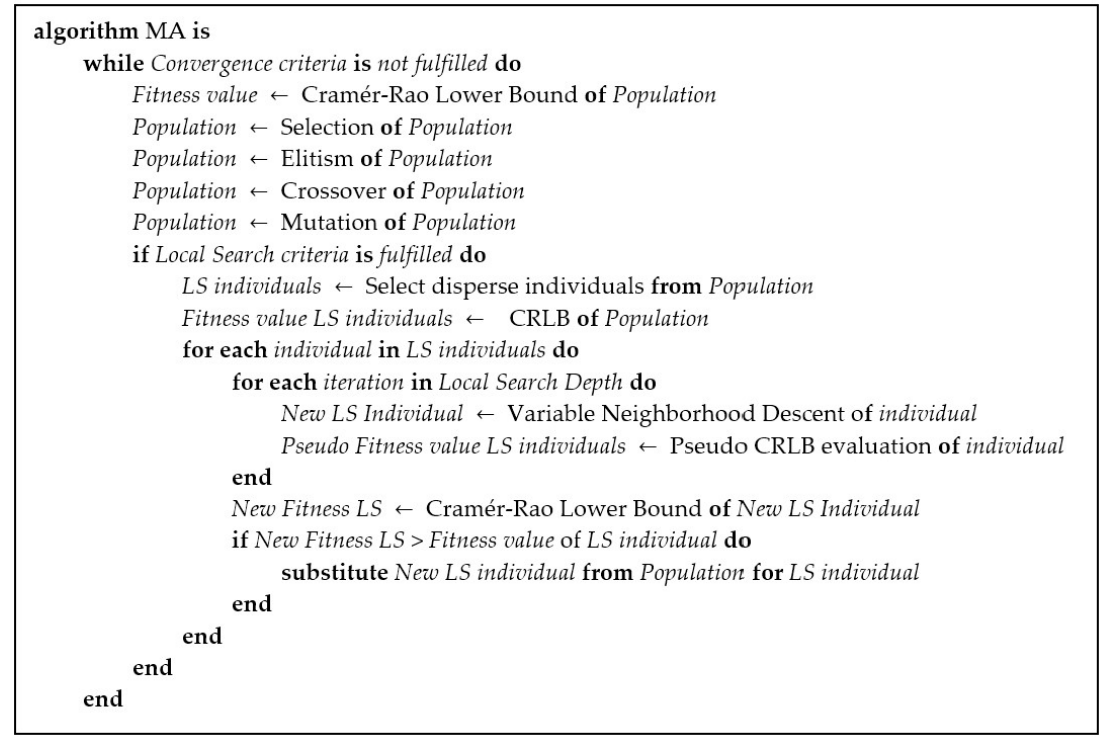
Figure 5. Memetic Algorithm (MA)